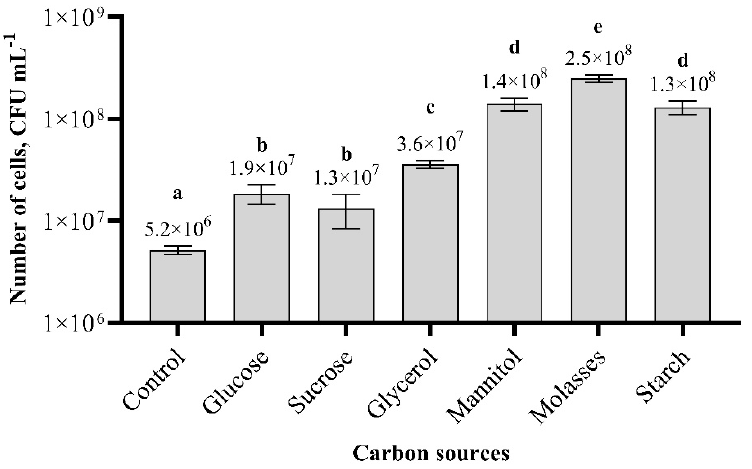
Figure 2. Effect of different carbon sources on Paenibacillus sp. MVY-024 biomass production. The values marked with the same letter have no significant difference at p ≤ 0.05.